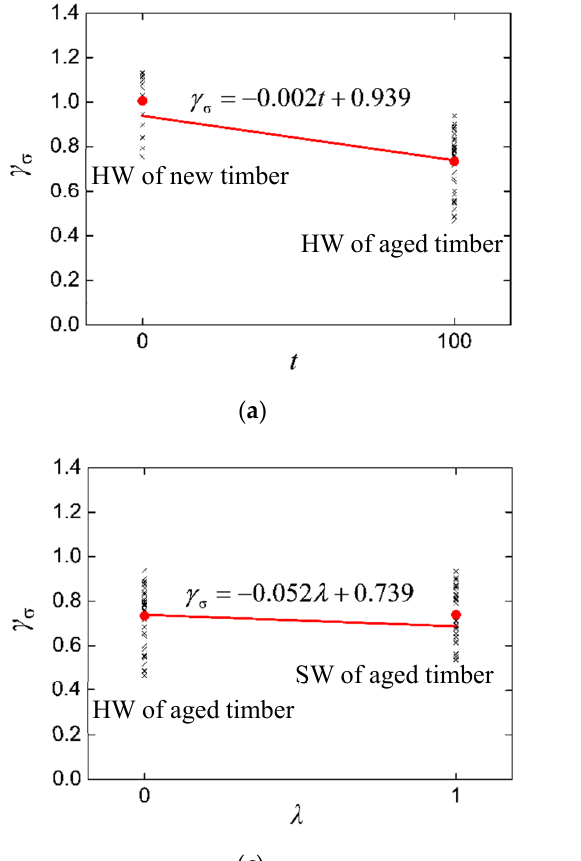
Figure 6. Distribution of the compressive strength ratio: ( a ) γ σ in 3D space; ( b ) boxplot of γ σ . The scattered points of γ σ in Figure 6a can be fitted to a linear plane distribution using the least-squares method: